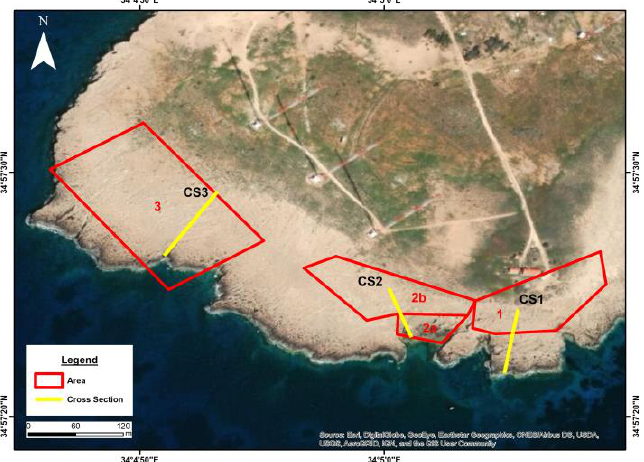
Figure 5. The investigated area at Cape Greco, the locations of the three cross-sections, and the division into four subareas, which are further discussed in the text. Base map sources: Esri, DigitalGlobe, GeoEye, i-cubed, USDA FSA, USGS, AEX, Getmapping, Aerogrid, IGN, IGP,